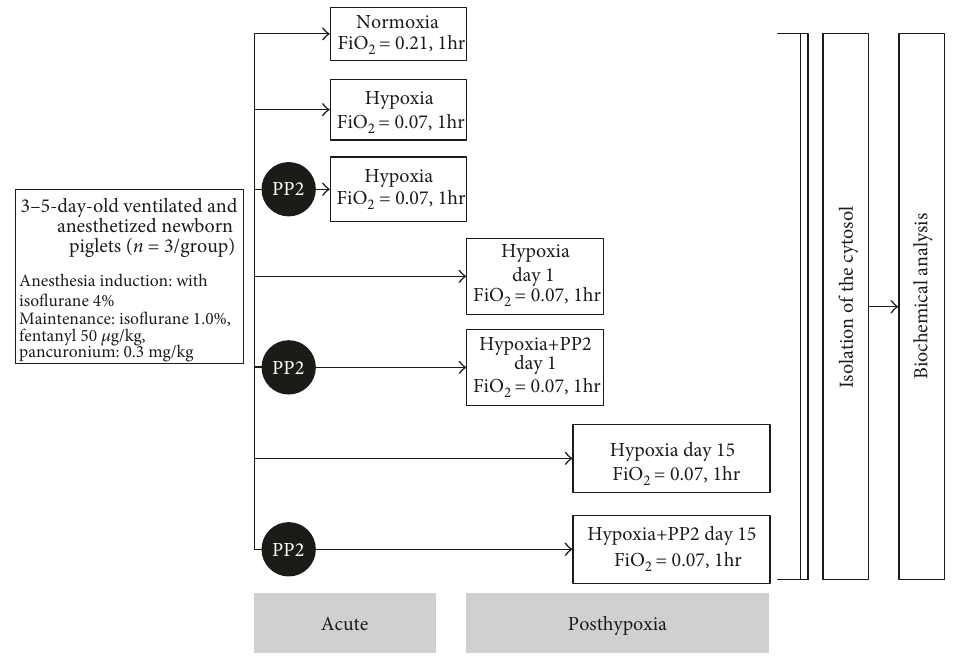
Figure 1: Experimental